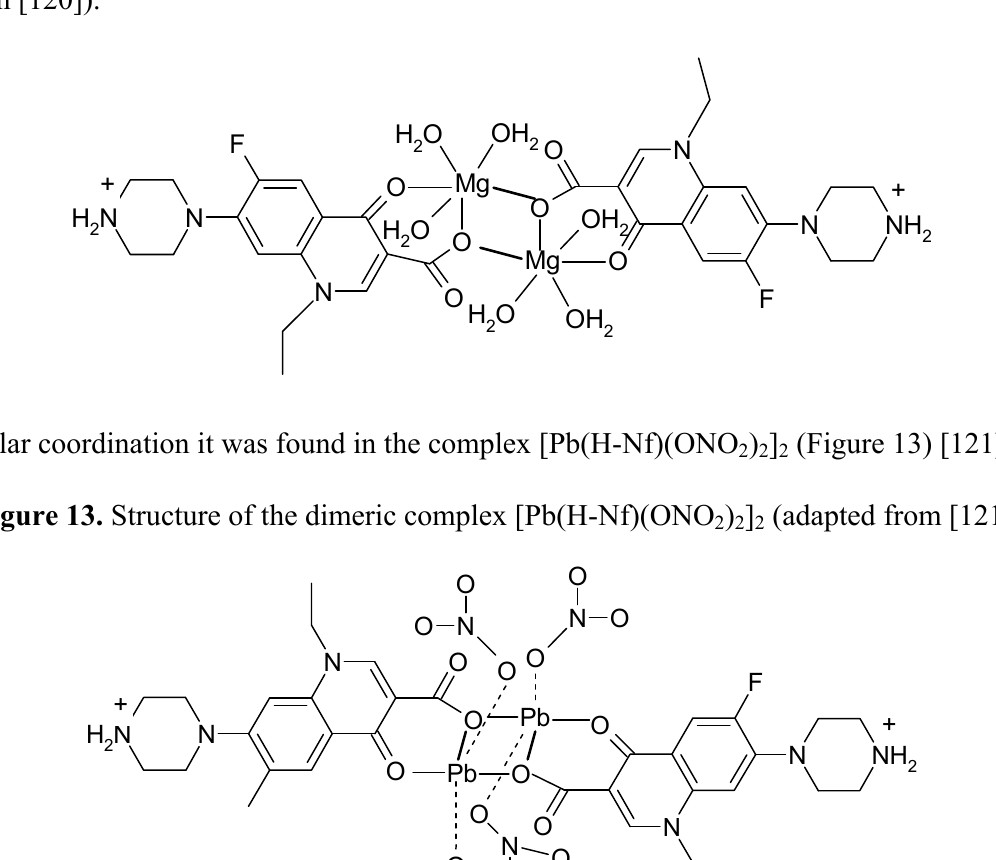
⋅ 4H (H O) (HNf) ]Cl O (adapted 2 2 6 2 4 2